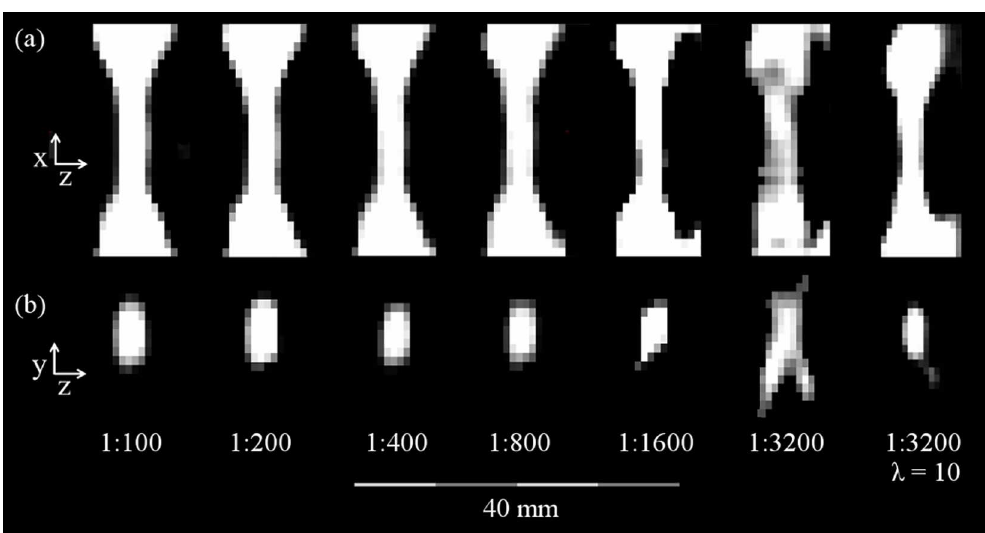
Fig 8. MPI-Images of the dilution series. Sagittal (a) and axial (b) slices extracted from reconstructed 3D image data of the 5 mm stenosis-phantom filled with the different Resovist dilutionsfrom 1:100–1:3200 in sagittal (a) and axial (b) reformationswith a regularization factor of λ = 1. Additionally, the image reconstruction of the Resovist dilutionof 1:3200with λ = 10 is shown. Note the distinct distortion of the image of the 1:3200dilutionreconstructed with λ = 1, which are smoothedby the higherregularization of λ = 10 due to the reducednoise (detaileddata in S4 Table).